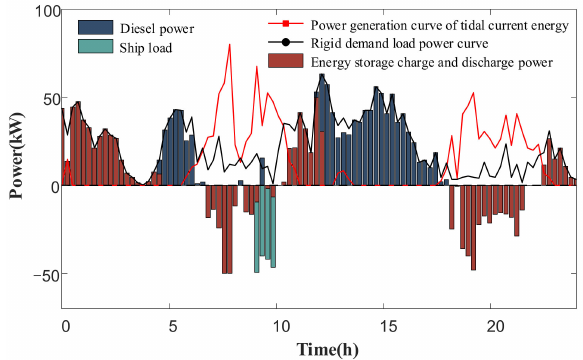
Figure 10. The results of the intraday